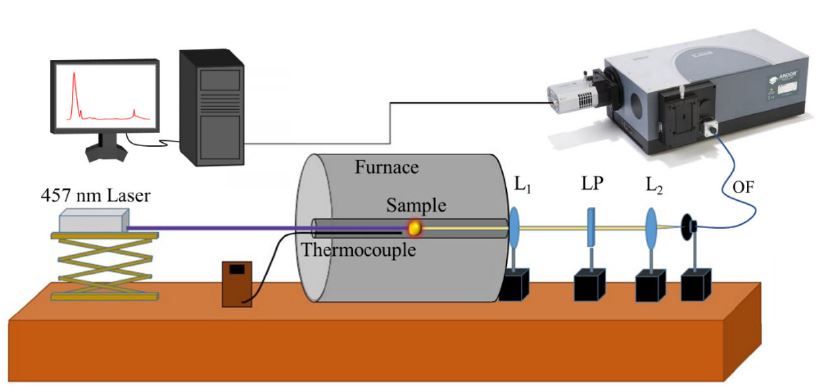
Figure 2. Experimental setup used for the temperature calibration of the emission